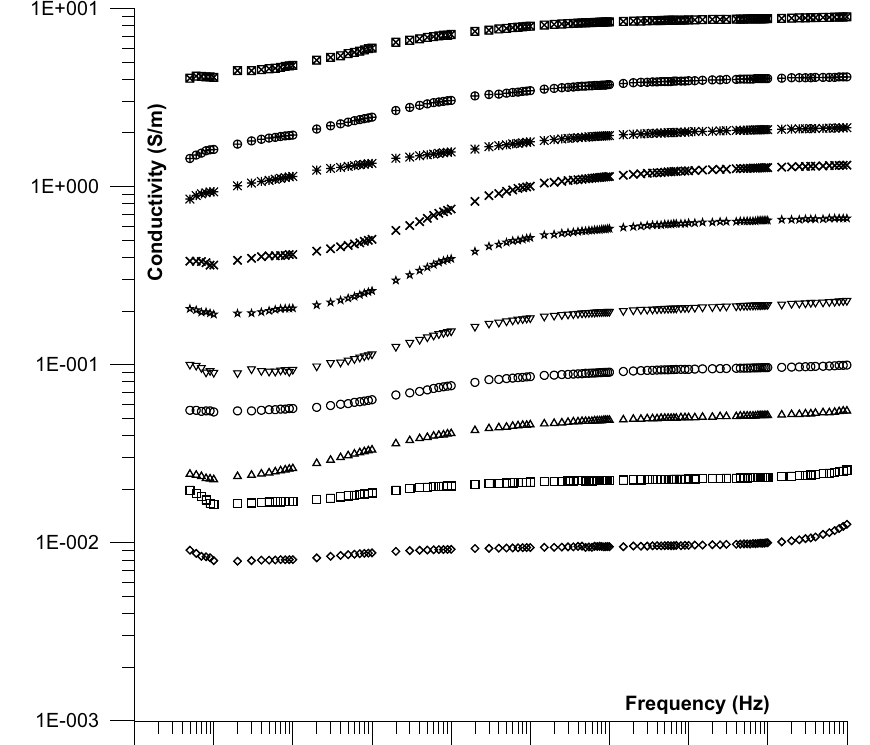
Fig. 2 Change in conductiv- ity with frequency at different saturation levels of saline water (4 g/100 g of NaCl) [(1) dia- mond, (2) square, (3) triangle, (4) circle, (5) inverted triangle, (6) times symbol, (7) star symbol, (8) asterisk, (9) oplus symbol, (10) open square with times